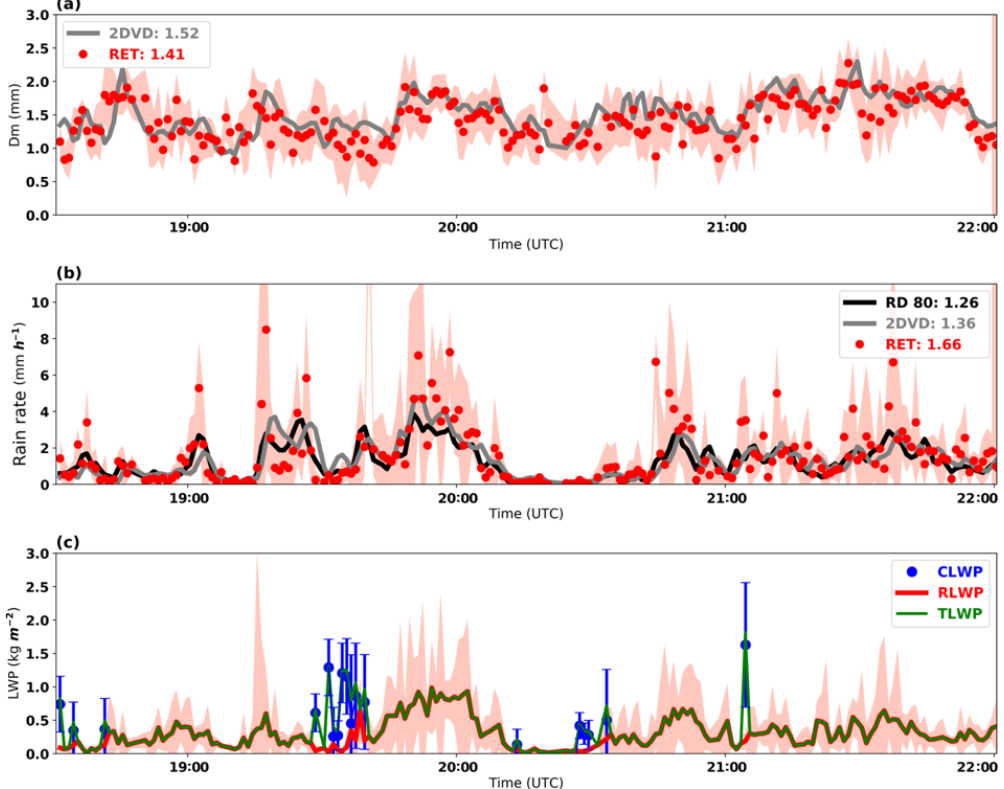
Figure 5. Time series of (a) retrieved (RET) (red dots) and 2DVD surface disdrometer estimated (grey lines) D m , (b) RET (red dots), 2DVD (grey line) and RD-80 (black line) surface disdrometer rain rate estimates, and (c) rain liquid water path (RLWP; red line), cloud liquid water path (CLWP; blue dots), and liquid water path (LWP = RLWP + CLWP, green lines) for Case B (11 May 2011). The red shading area and blue bars are the estimated retrieval uncertainties for rain microphysical properties ( D m , rain rate, and RLWP) and